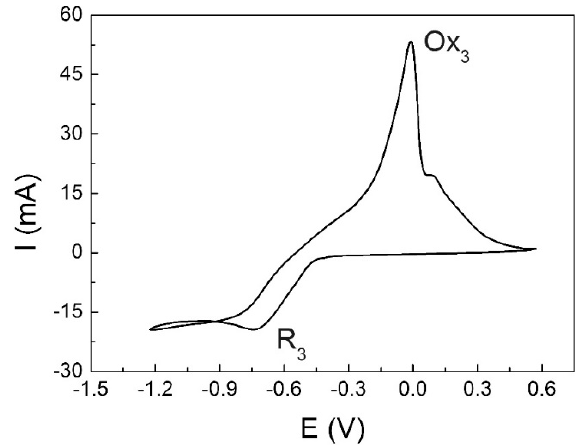
Figure 5. The cyclic voltammogram obtained in the NaCl–KCl–NaF–K 2 NbF 7 melt. C K2NbF7 = 5.05 × 10 − 4 mol·cm − 3 , ν = 0.1 V·s − 1 , t = 750 ° С , C (Na 2 O) = 5 × 10 − 4 mol·cm − 3 .